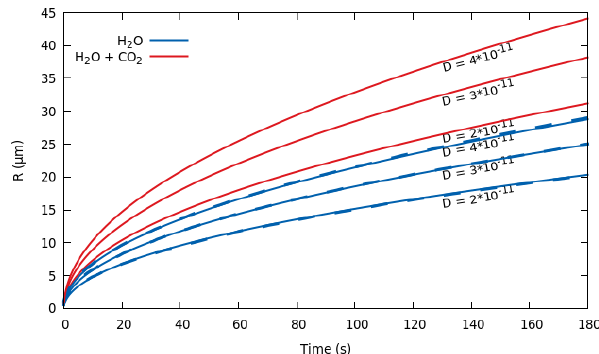
Figure 8. Temporal evolution of bubble radius for an instan- taneous decompression from p 0 = 150MPa to p L = 120MPa. In blue is the comparison between the MagmaFOAM model multiComponentODERPShellDStatic (solid lines) and nu- merical solutions from Lyakhovsky et al. (1996) (dashed lines) that practically coincide for three different values of the diffu- sion coefficient of H 2 O. The red lines represent the same simu- lations with 1wt% of CO 2 added in the melt. The diffusion co- efficient of CO 2 is 1 order of magnitude smaller than H 2 O. Ini- tial conditions and parameters (see Appendix B) in all simula- tions are ρ L = 2300kgm − 3 , µ = 5 × 10 4 Pas, σ = 0 . 06Nm − 1 , T = 1123K, p G (t = 0 ) = p 0 + 2 σ/R(t = 0 ) , R(t = 0 ) = 10 − 7 m, = 0 . 053wt%. Saturation concentration S 0 = 2 × 10 − 4 m, and C 0 H 2 O is computed using SOLWCAD (Papale et al.,